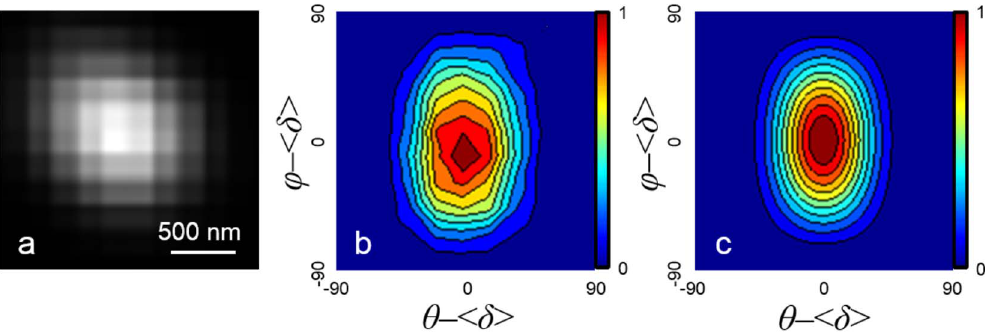
Figure 5. PIPO THG data of an H-aggregate of astaxanthin. (a) THG image of an astaxanthin H-aggregate along with (b) the measured PIPO THG data and (c) the PIPO THG fit performed with equation